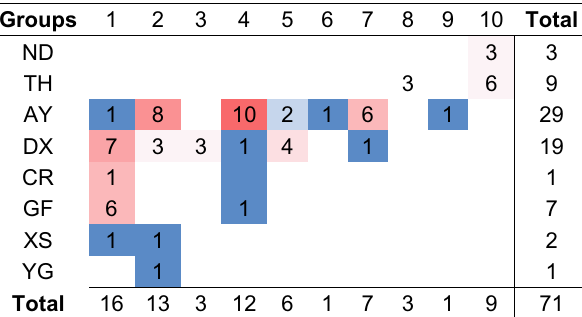
Table 3. Distribution of different groups of ALV strains in different farms. The same number is covered with the same color.